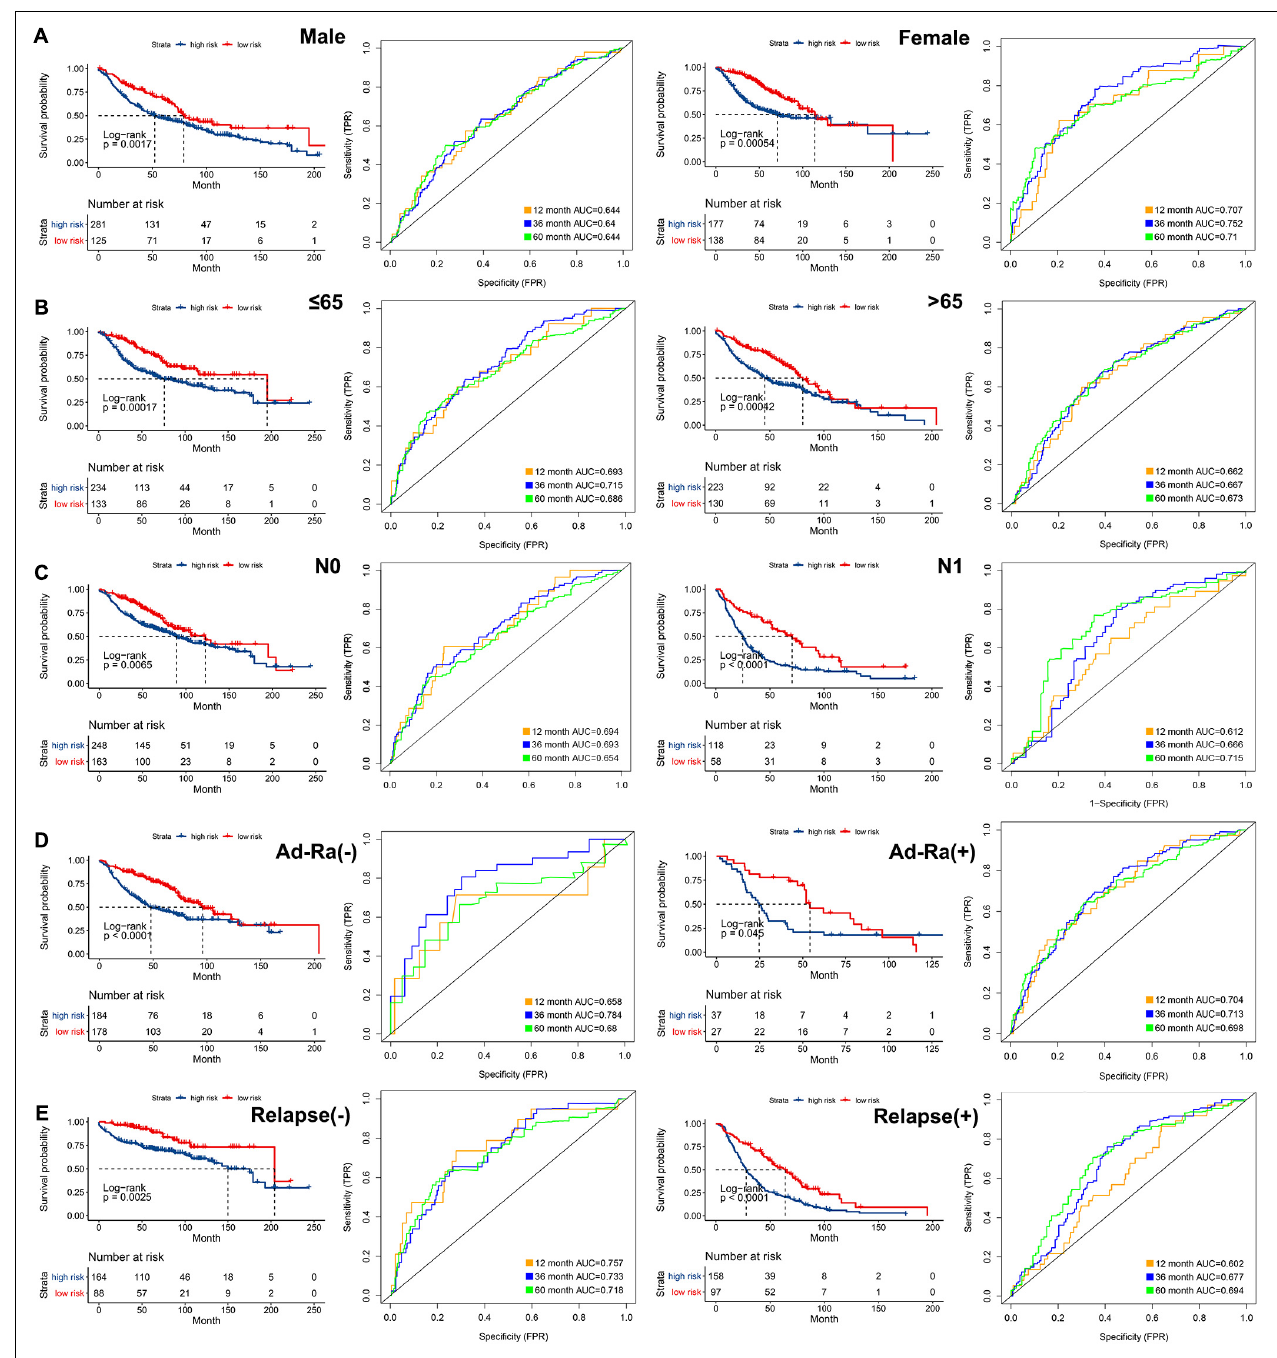
FIGURE 4 | The AUC of the ROC that was computed by the signature under diverse situations. Survival analysis of the high and low groups and the AUC of the ROC in (A) gender, (B) age, (C) status of node metastasis, (D) whether they received adjuvant radiotherapy, and (E) whether relapsed.